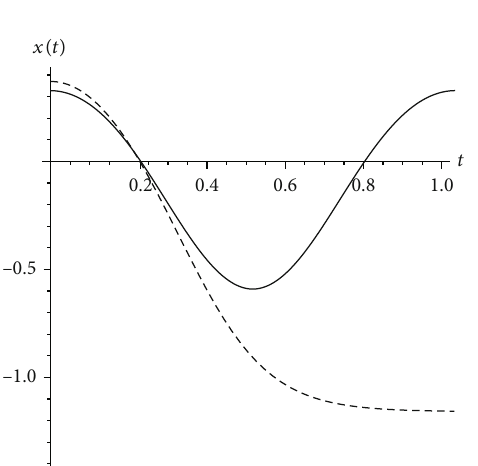
Figure 3: The phase portrait of system (24).